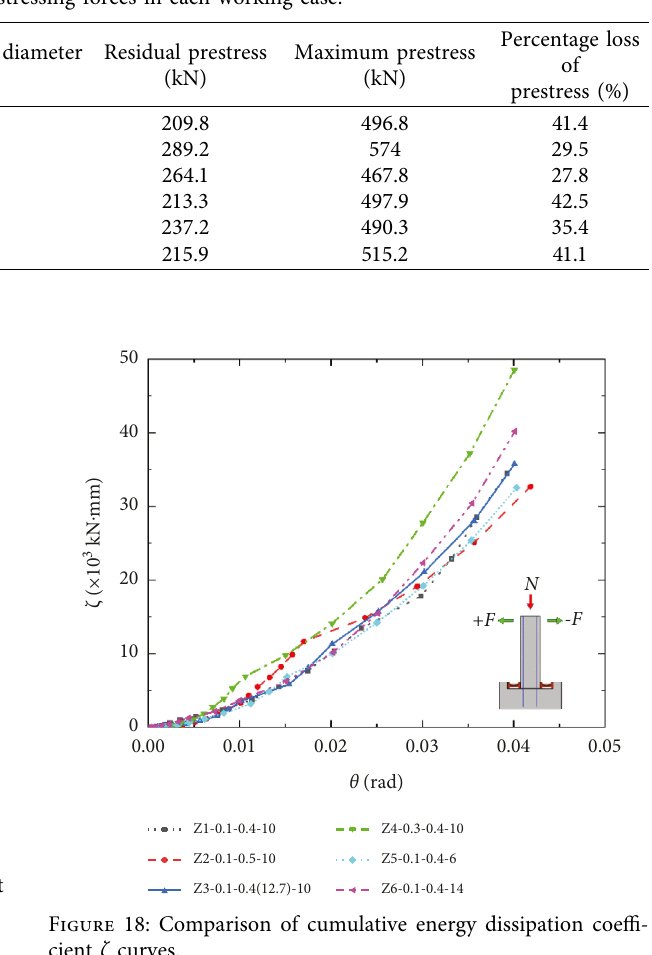
Table 6: The test results of prestressing forces in each working case.